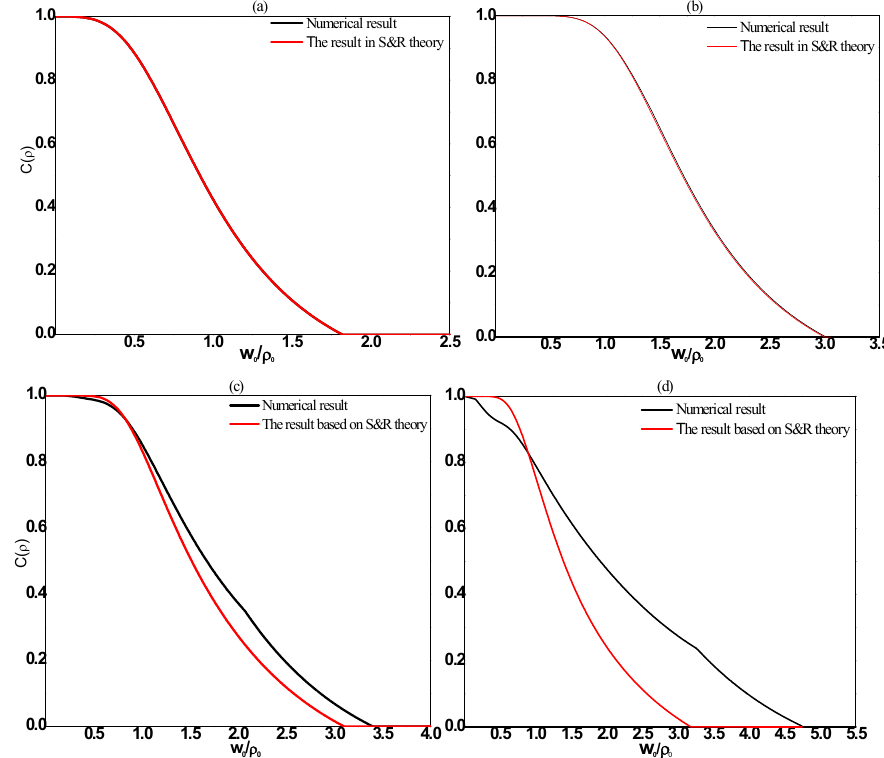
Figure 2. Concurrence plotted as a function of ratio w 0 / ρ 0 (the turbulence strength) for different OAM modes. In ( a ) (cid:96) = 1, p = 0, in ( b ) (cid:96) = 3, p = 0, in ( c ) (cid:96) = 3, p = 1, in ( d ) (cid:96) = 3, p = 1, [9].